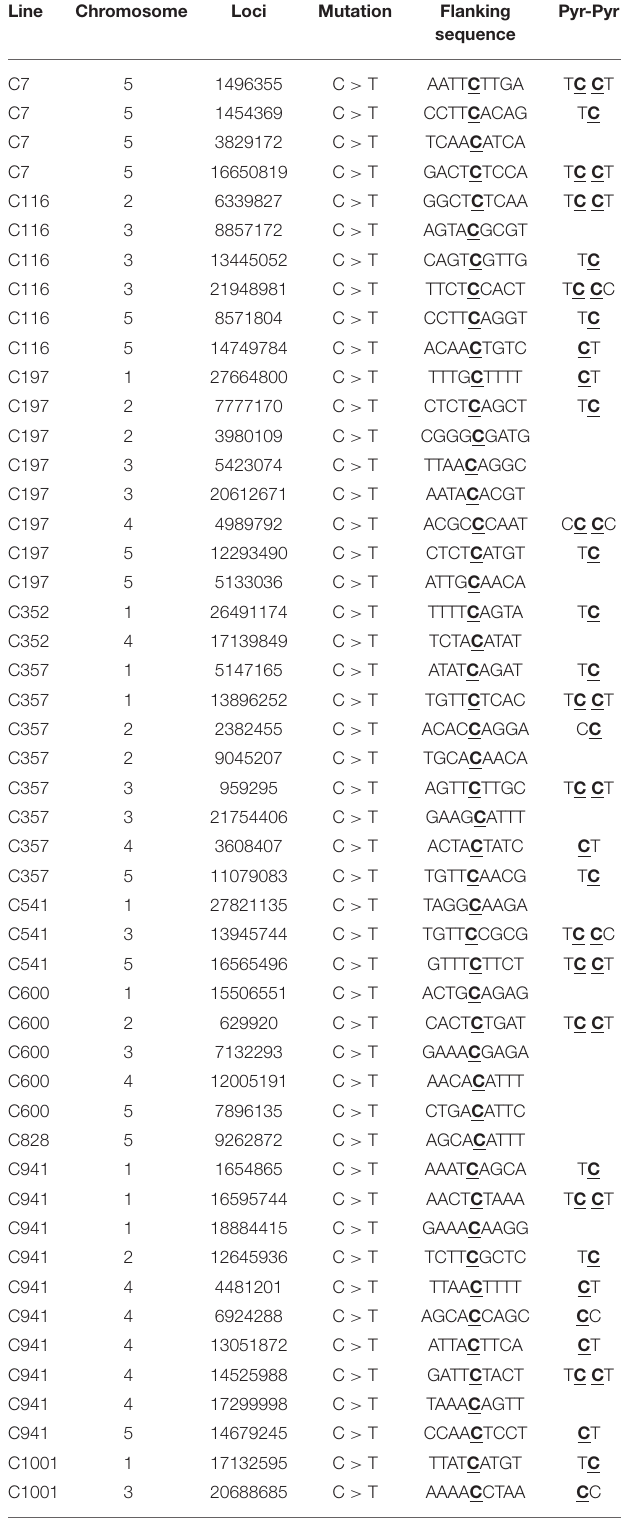
TABLE 3 | Pyrimidine dinucleotide analyses at C > T substitutions sites in 11 CIB irradiated M3 lines.